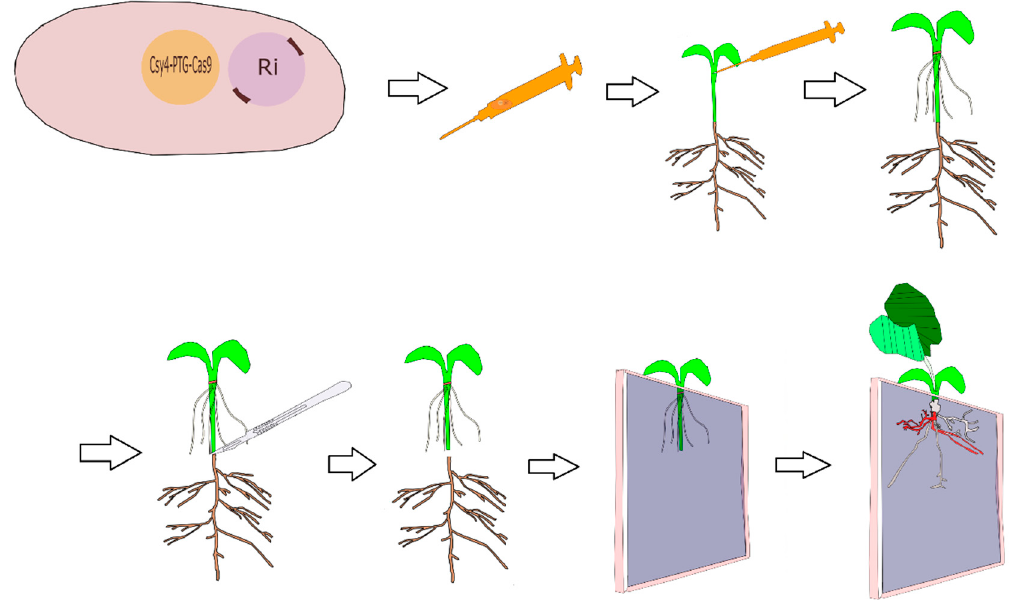
Figure 4. The whole procedure of Agrobacterium rhizogenes -mediated hairy root transformation of soybean cotyledonary node with CRISPR/Cas9 system and real-time monitoring of transformed hairy roots using RUBY reporter gene for efficient “in root” gene functional analysis.